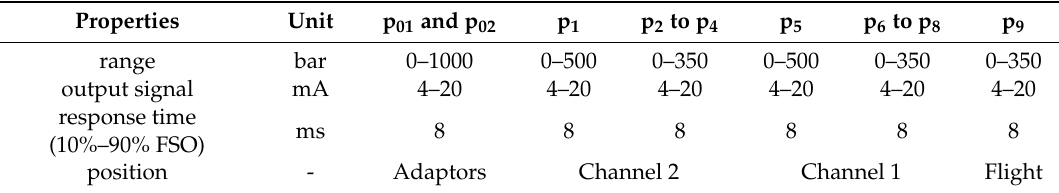
Table 5. Positions and technical properties of pressure transducers. FSO: full scale output. Table 4. Geometrical parameters of the flow channels.